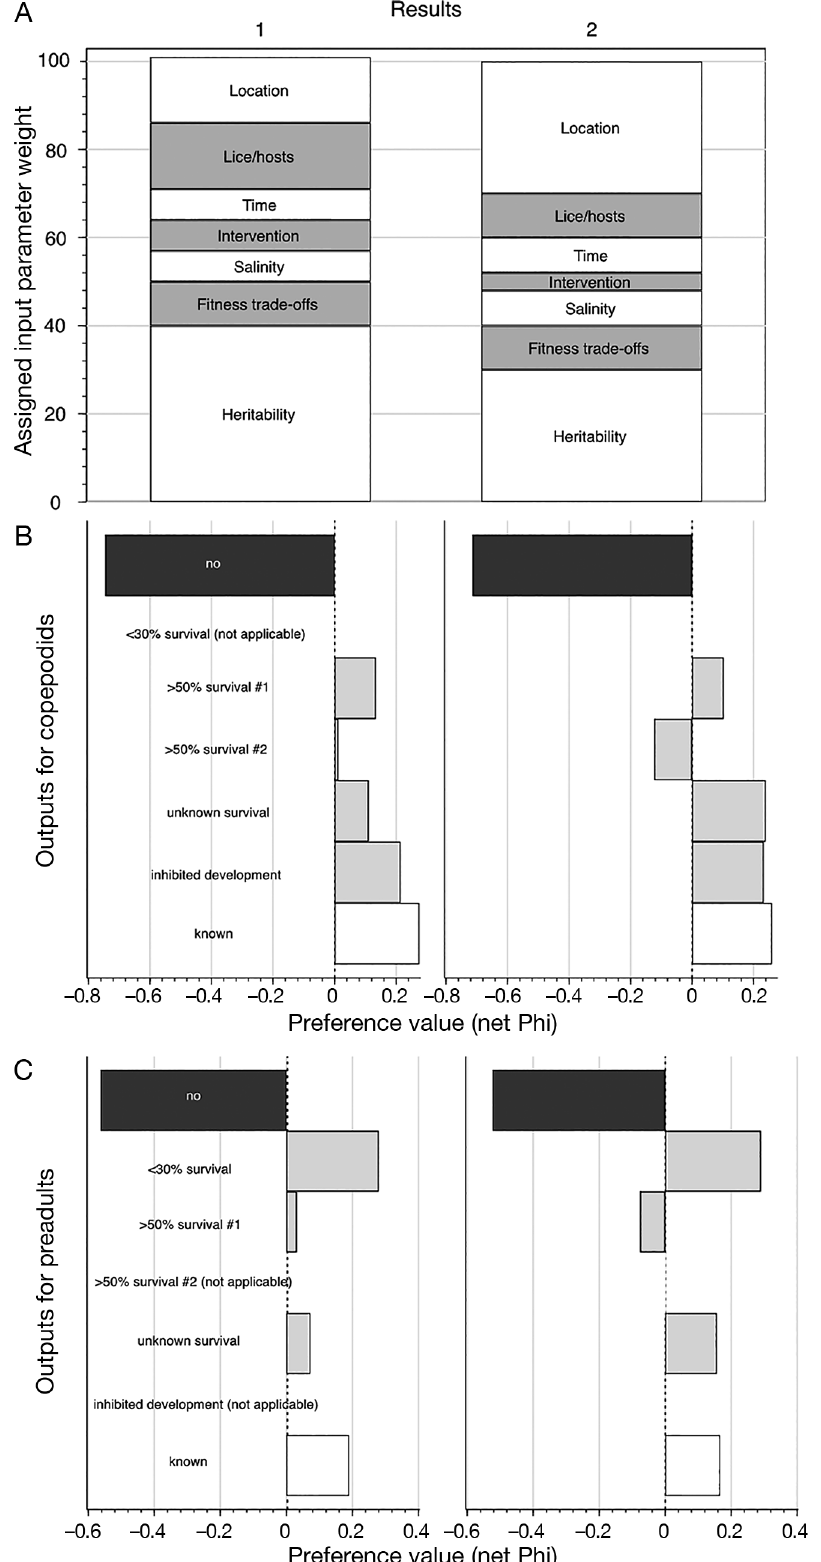
Fig. 3. Changes in net phi values (prefer- ence) by sea lice life stage: (B) copepod; (C) preadult, of different degrees of freshwater tolerance occurring, according to weights presented in (A). The 2 result options are based on 2 different combined-weighting schemes assigned to the following factors and subfactors. 1: genetics = 50% (with her- itability = 80% and fitness trade-offs = 20%), exposure = 20% (with salinity, intervention, and time each 33%) and population/envi- ronment = 30% (with lice/hosts and location each 50%); 2: genetics = 40% (with heri- tability = 75% and fitness trade-offs = 25%), exposure = 20% (with salinity and time each 40% and intervention = 20%) and popula- tion/environment = 40% (with lice/hosts = 25% and location =